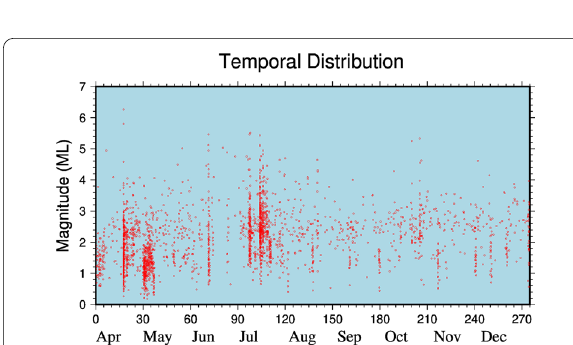
Fig. 2 The temporal distribution of seismicity in the upper 40 km beneath this area observed from April to December of 2021. Several swarm activities can be identified, in which intense seismicity happened within a short time interval. The main earthquake swarms occurred from April to July of 2021. Numbers indicate the days